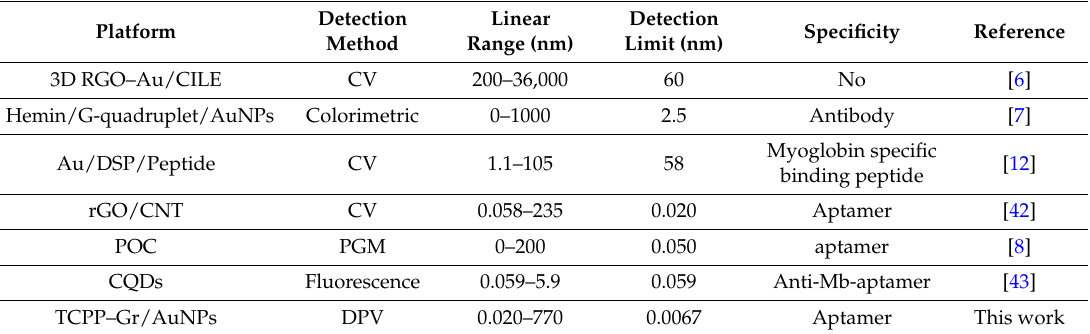
Table 1. The comparison of different analytical methods for myoglobin detection.